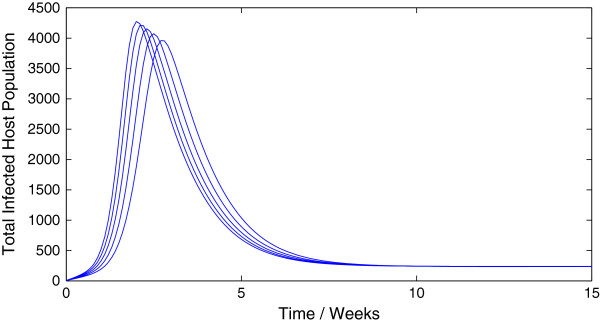
Sample trajectories of model (1.1) with R0 > 1.